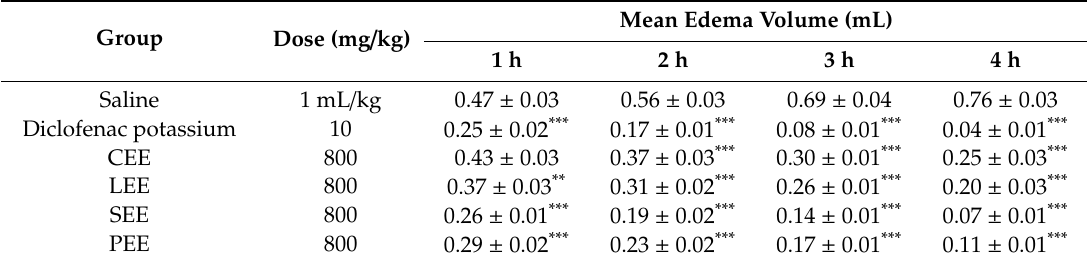
Table 2. Anti-inflammatory e ff ect of C. sativus ethanolic extracts.